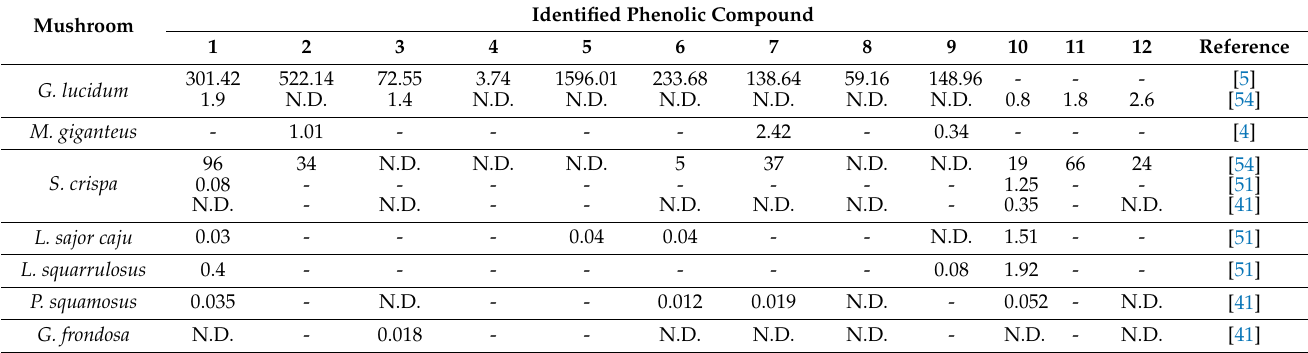
Table 2. Phenolic compounds content in Polyporales mushrooms (mg/100g dw).